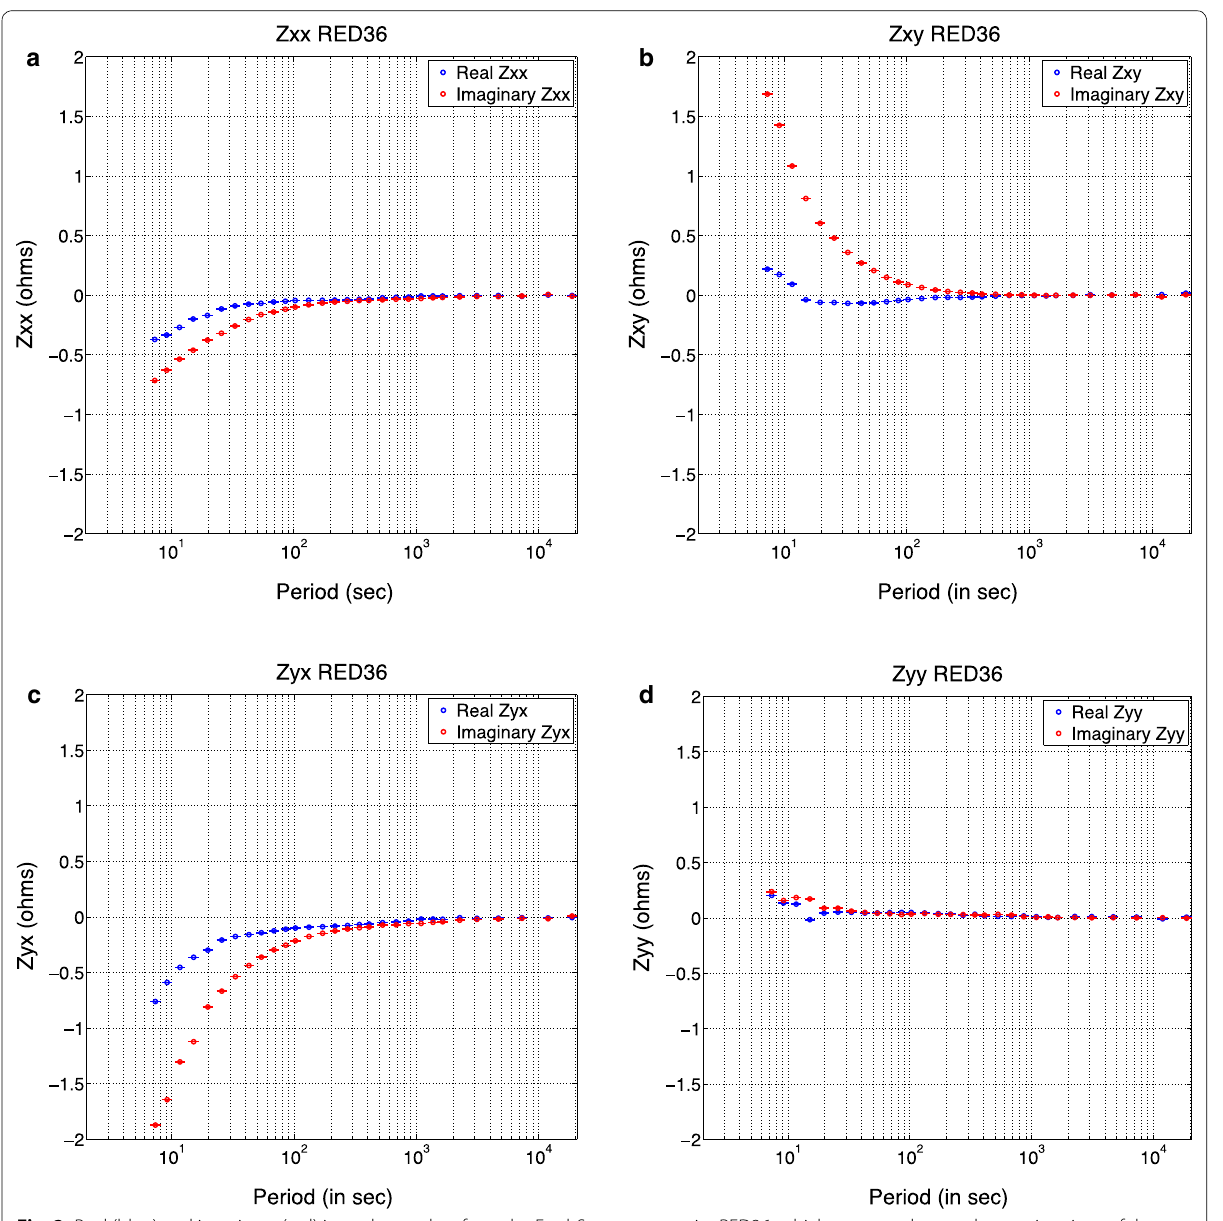
Fig. 2 Real (blue) and imaginary (red) impedance plots from the EarthScope survey site RED36, which were used to produce estimations of the geoelectric field with the Brandon (BRD) observatory geomagnetic time